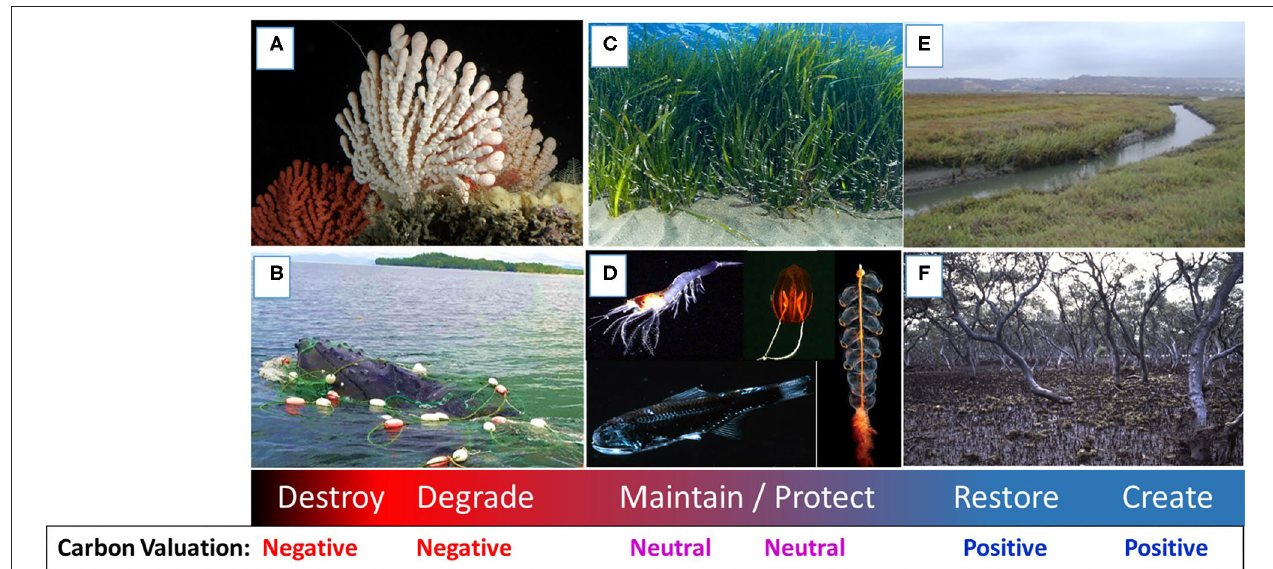
FIGURE 1 | Examples of ecosystems and processes along a gradient of actions that can have negative, neutral or positive effects on carbon storage. (A) Demersal fishing gear has destroyed many ancient deep-sea coral reefs in the past 30 years, and none have been restored (photo credit JAGO-Team/IfM-GEOMAR). (B) Whale populations have been decimated by hunting, ship strikes or entanglement in plastic fishing nets, lowering their ability to transfer carbon from the surface ocean to the deep-sea. (C) Seagrass beds can store large amounts of carbon but have been in decline worldwide, requiring protection for those that remain (credit C Vasapollo). (D) Pelagic animals such as mesopelagic fish draw carbon down from the shallows to great depths, their populations need to be maintained to protect this ecosystem service. Coastal developments have removed most saltmarshes (E) and mangrove forests (F) worldwide, requiring efforts to restore or recreate these important natural carbon